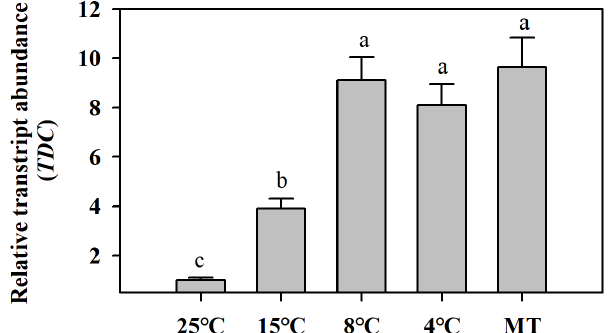
Figure 1. Low temperatures and exogenous melatonin induce the expression of melatonin biosynthetic gene TDC . Tomato plants at the 6-leaf stage were exposed to di ff erent low temperatures for 12 h and leaf samples were collected for the determination of chilling-induced TDC expression by quantitative RT-PCR. Exogenous melatonin (MT, 100 µ M) was sprayed on tomato leaves 12 h prior to the collection of leaves for analysis of TDC transcript abundance by quantitative RT-PCR. The expression level of TDC in tomato leaves at 25 ◦ C was set to 1, and the relative expression levels in the rest of samples were calculated accordingly. The values presented are means ± standard deviations (SDs; n = 3). Di ff erent letters (a,b,c) above bars indicate significant di ff erence at p < 0.05 among